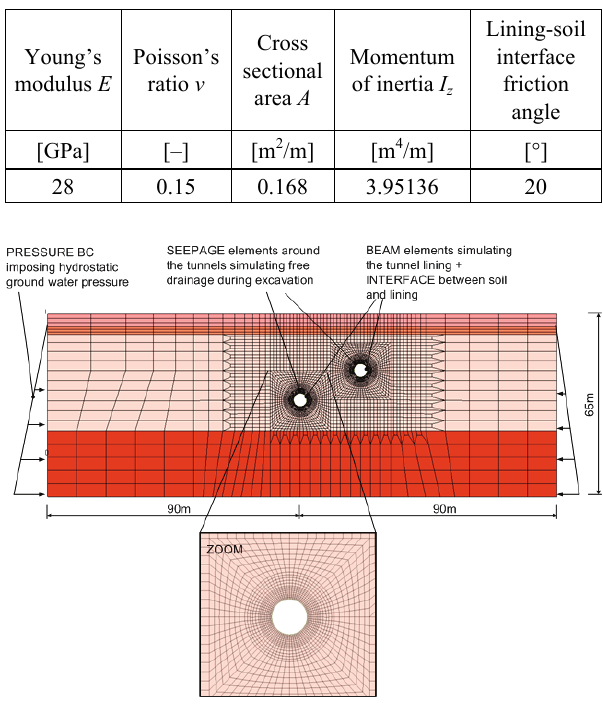
Fig. 7. Finite element mesh